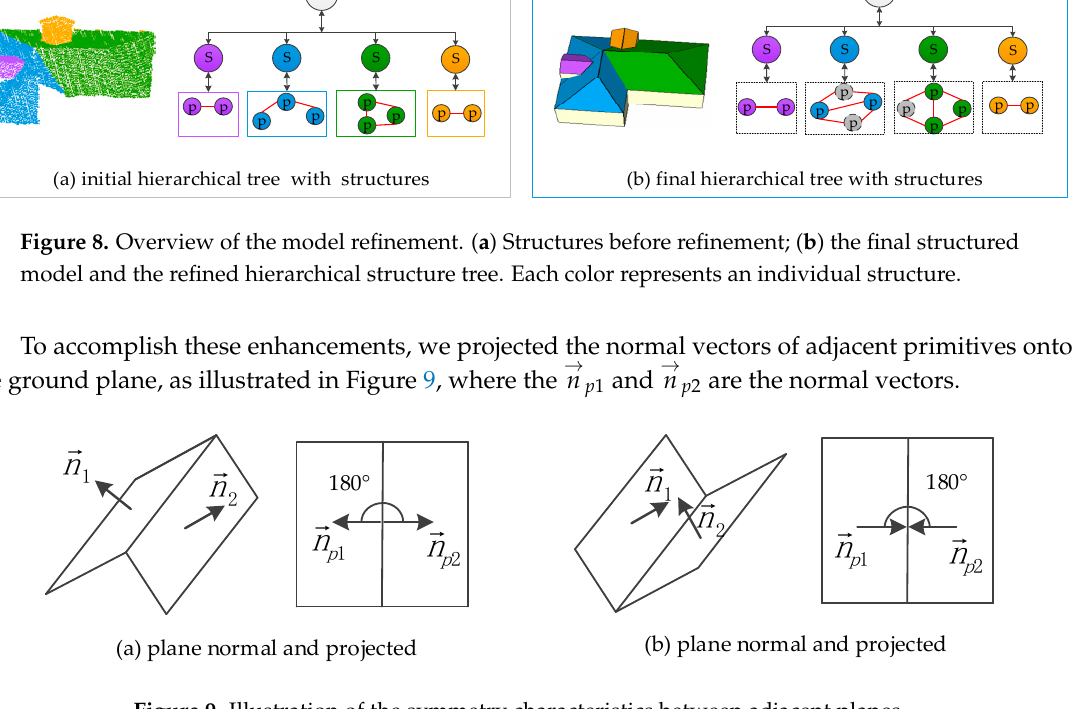
Figure 9. Illustration of the symmetry characteristics between adjacent planes.